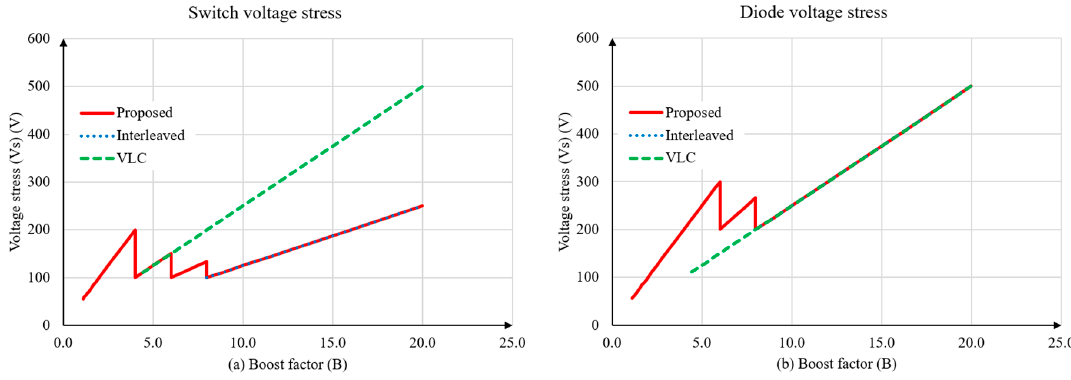
Figure 14. The comparison of voltage stress on switches ( a ) and diodes ( b ).